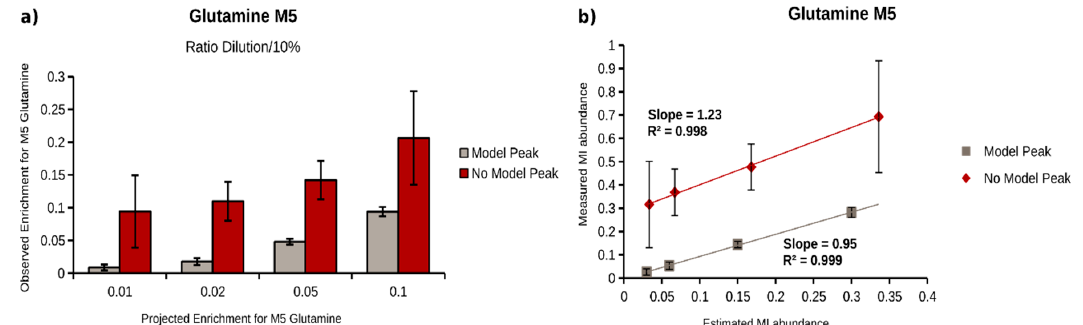
Figure 4. MID calculation of glutamine M5 obtained from labeled A549 cell extract diluted in plasma (0.1, 0.2, 0.5, and 1% of the original 13 C enrichment) with (gray) and without model peak correction (red)—( a ) Barplot of calculated (saturated) and estimated (transparent) glutamine M5 abundance with (gray) and without (red) model peak correction; ( b ) scatter plot of estimated vs measured glutamine M5 abundance, with (gray) and without (red) model peak correction for linear regression analysis.